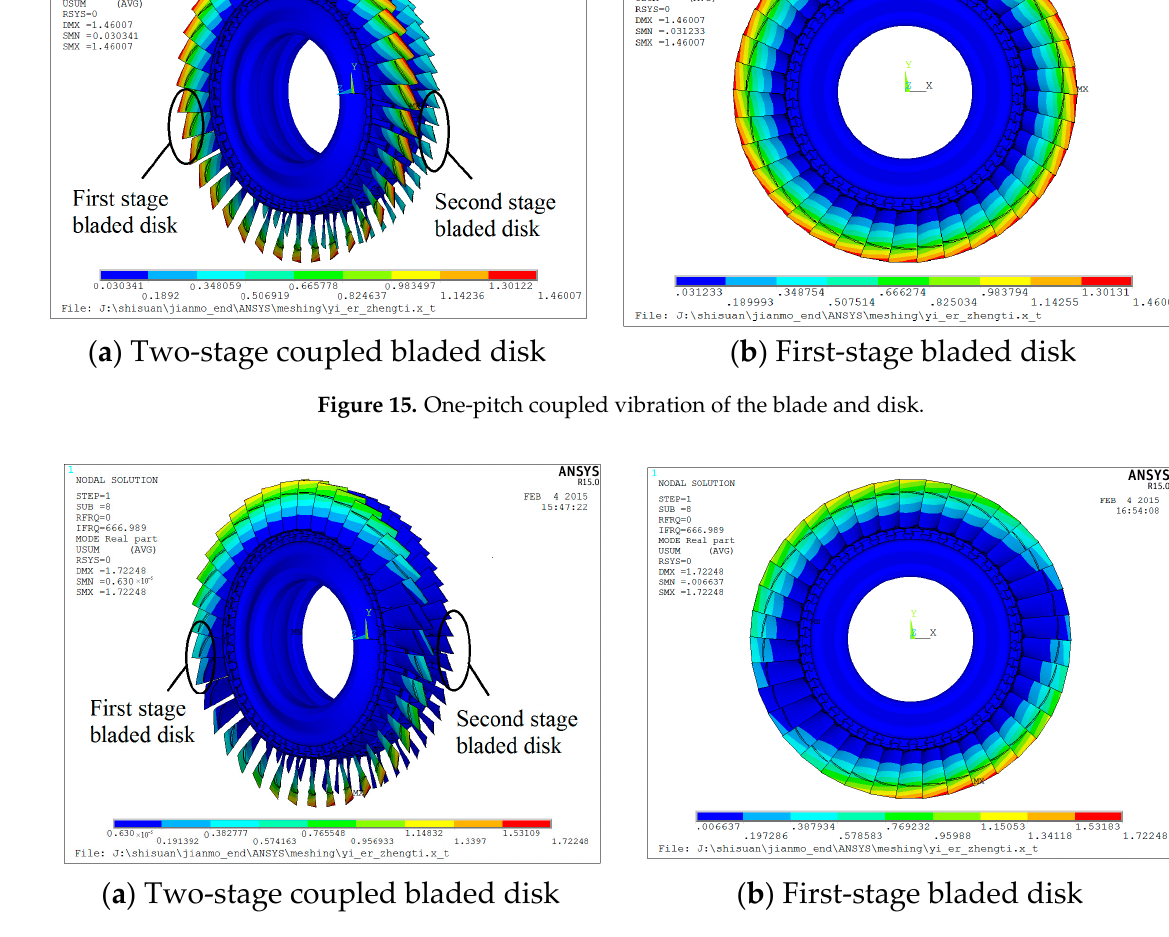
Figure 16. One-pitch coupled vibration of the blade and disk.